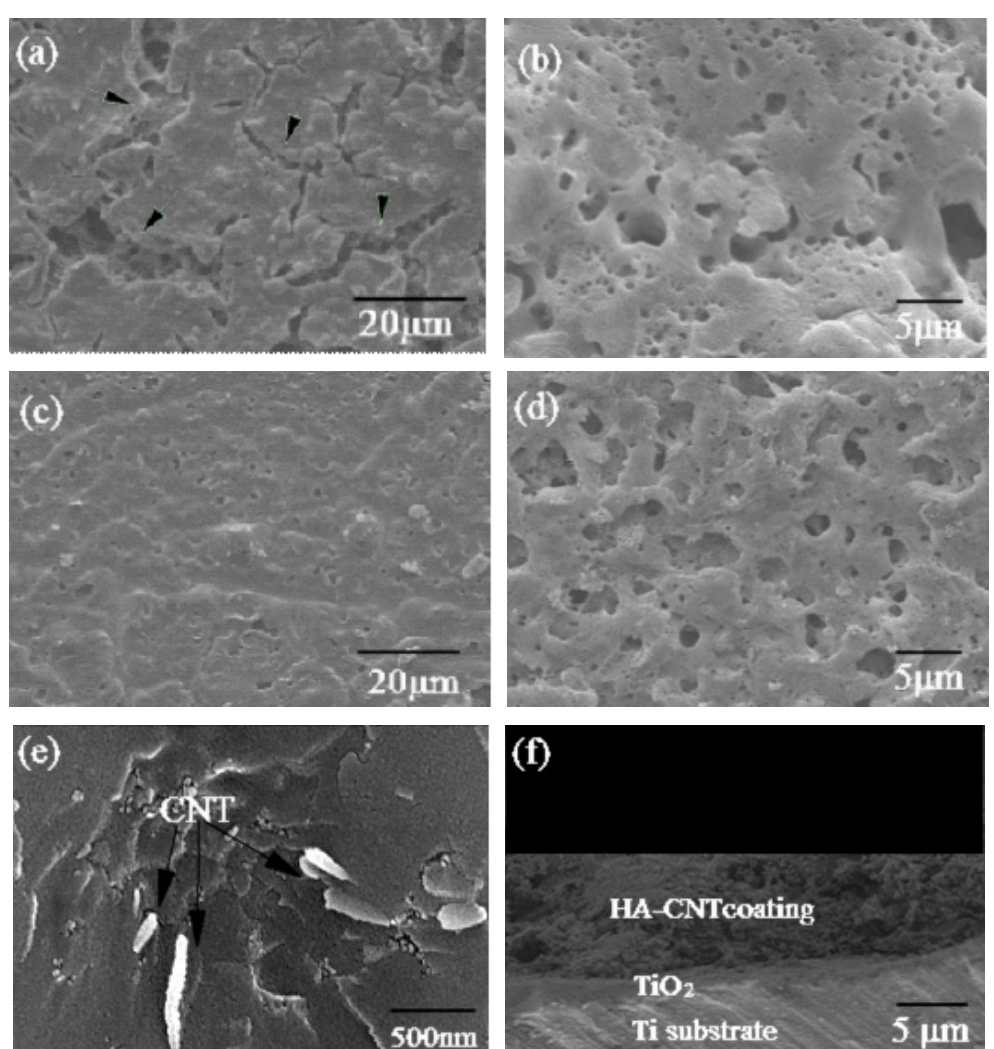
Figure 4. SEM images of the two coating systems on Ti substrate: ( a ) HA coating; ( b ) HA coating at high magnification; ( c ) HA-CNT/TiO double layer coating; ( d ) HA-CNT/TiO 2 at high magnification; ( e ) micrograph of the fracture surface of the HA-CNT/TiO double layer coating cross-sectional layer coating; ( f ) HA-CNT/TiO 2